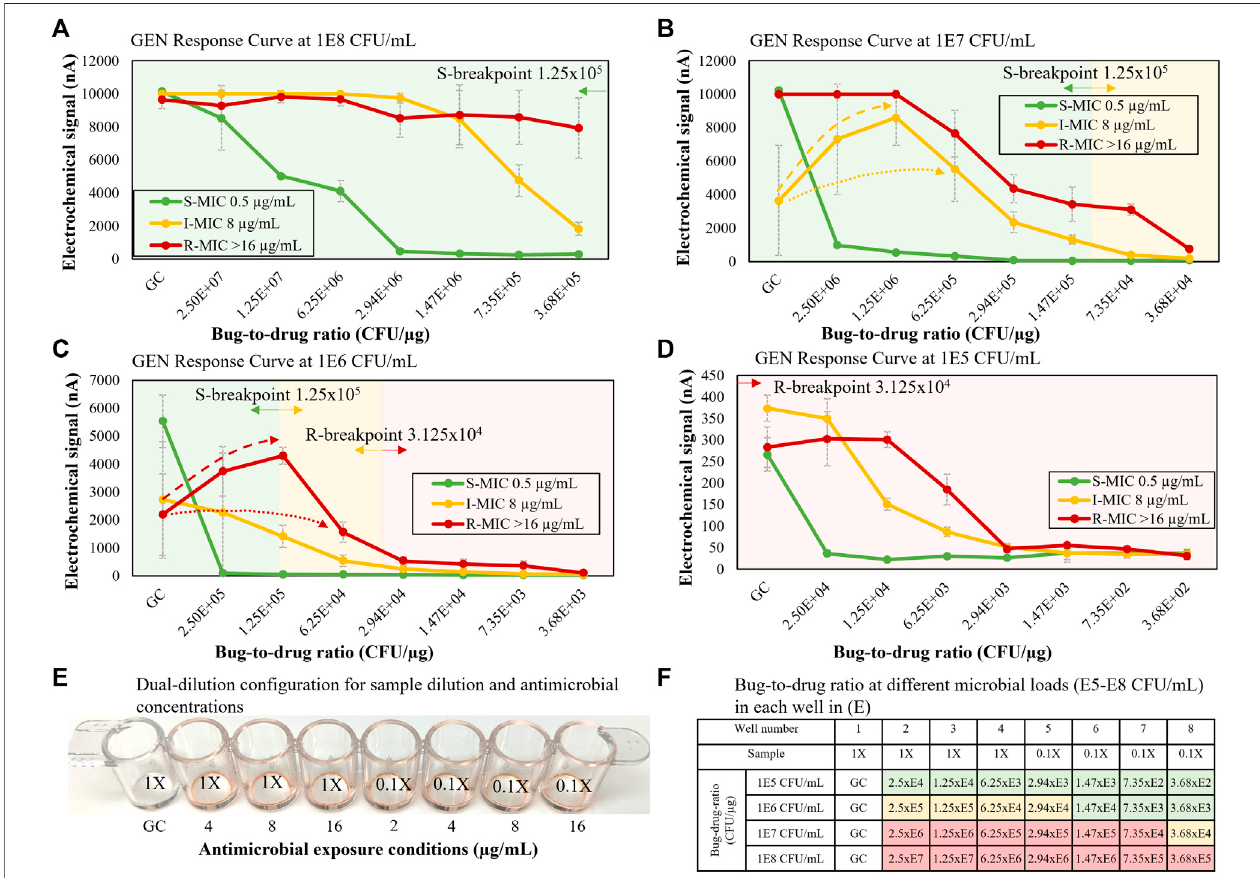
FIGURE 8 | (A – D) Gentamicin S, I, R response curves for microbial loads of 10 5 – 10 8 CFU/ml. (E) Stripwell con fi guration used for the dual-dilution microbial response curves shown in (A – D) . (F) Bug-to-drug ratios for different microbial loads from 10 5 to 10 8 CFU/ml with relation to S and R breakpoints. Green cells represent bug-to-drug ratios lower than an inoculum concentration of 5 × 10 5 CFU/ml with the S breakpoint antimicrobial concentration. Red cells represent bug-to-drug ratios higher than an inoculum concentration of 5 × 10 5 CFU/ml with the R breakpoint antimicrobial concentration. Yellow cells represent intermediate microbial responses between S and R